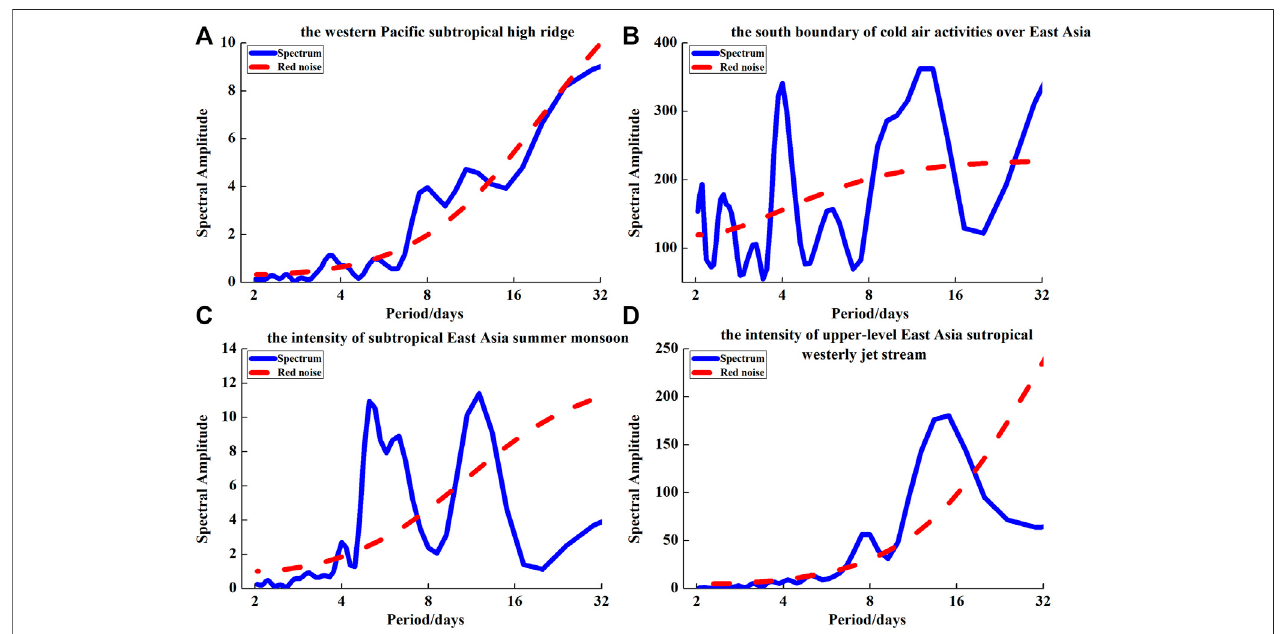
FIGURE 7 | Noise power spectrum analysis of series of daily index of western Paci fi c subtropical high (WPSH) ridge (A) , south boundary of cold air over East Asia (B) ,intensityofsubtropicalEastAsiasummermonsoon(SEASM) (C), andintensityofupper-levelEastAsiasubtropicalwesterlyjet (D) inJuneandJuly2020(dashedred line is for red noise